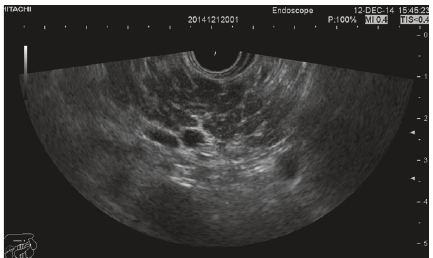
Figure 2: Honeycombing and hypoechoic appearance of pancreas with linear EUS.